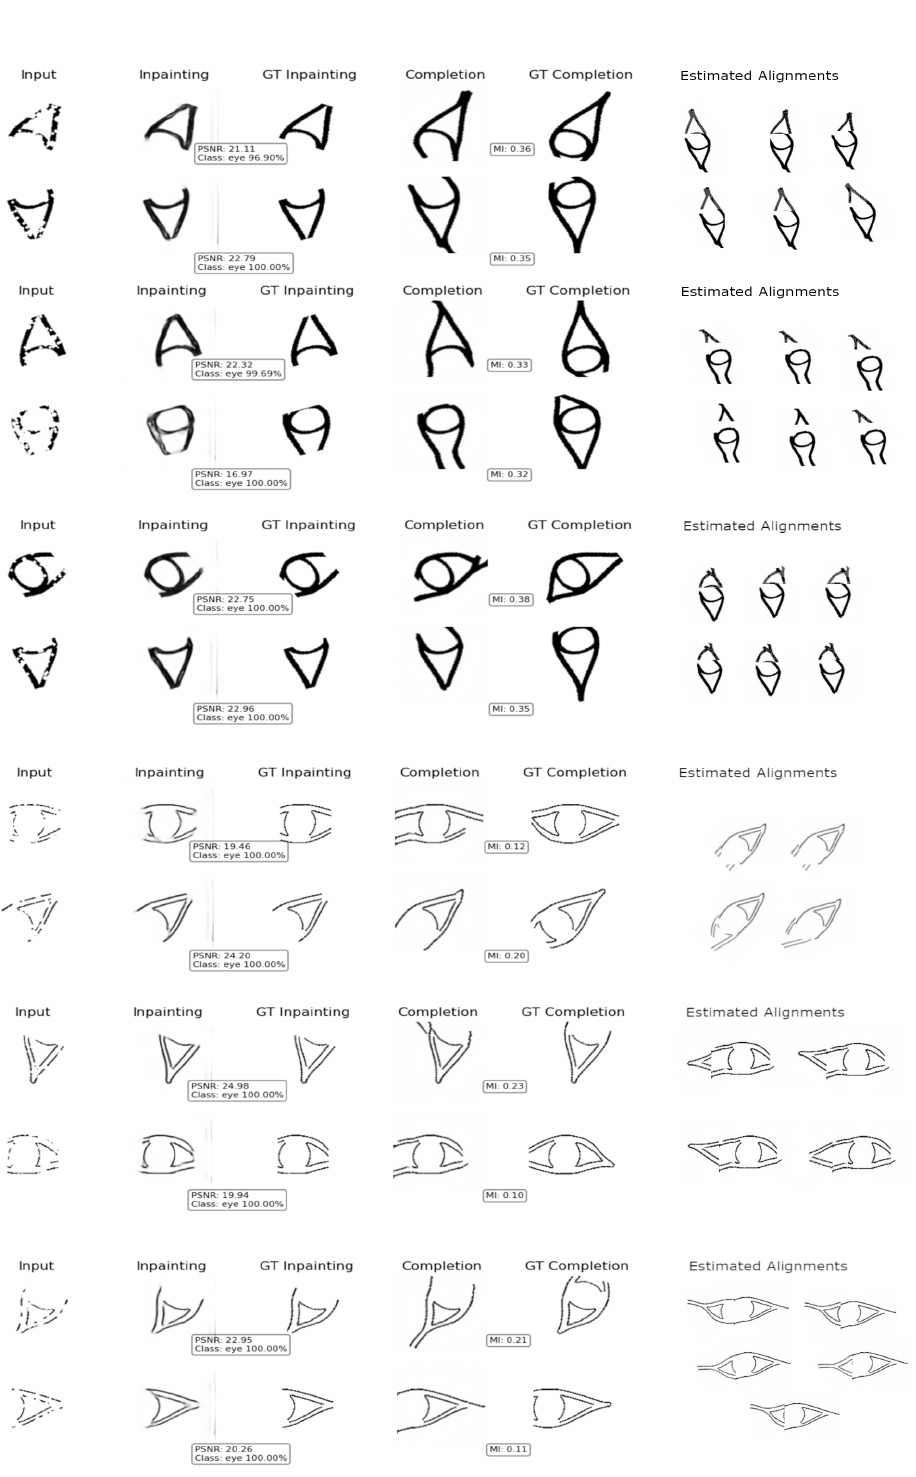
Figure 15. Examples of obtained results for the eye sign. From inpainting to